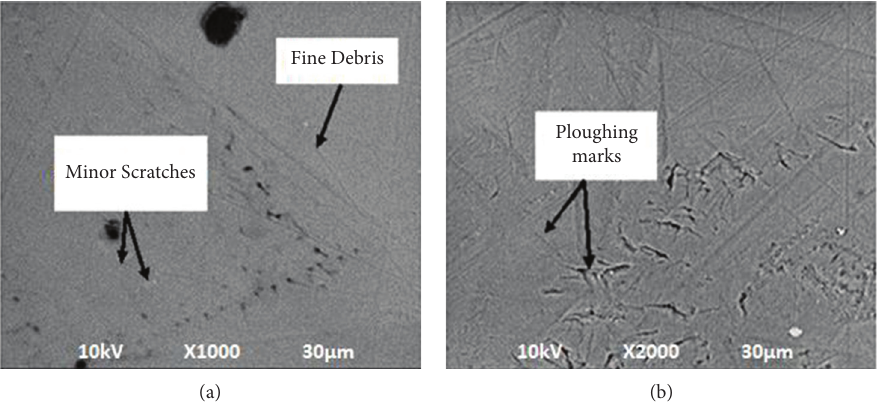
Figure 12: (a) SEM micrograph of worn alkali-treated polypropylene (T +PP) sample at 9.81N and (b) SEM micrograph of worn alkali- treated polypropylene (T+PP) sample at